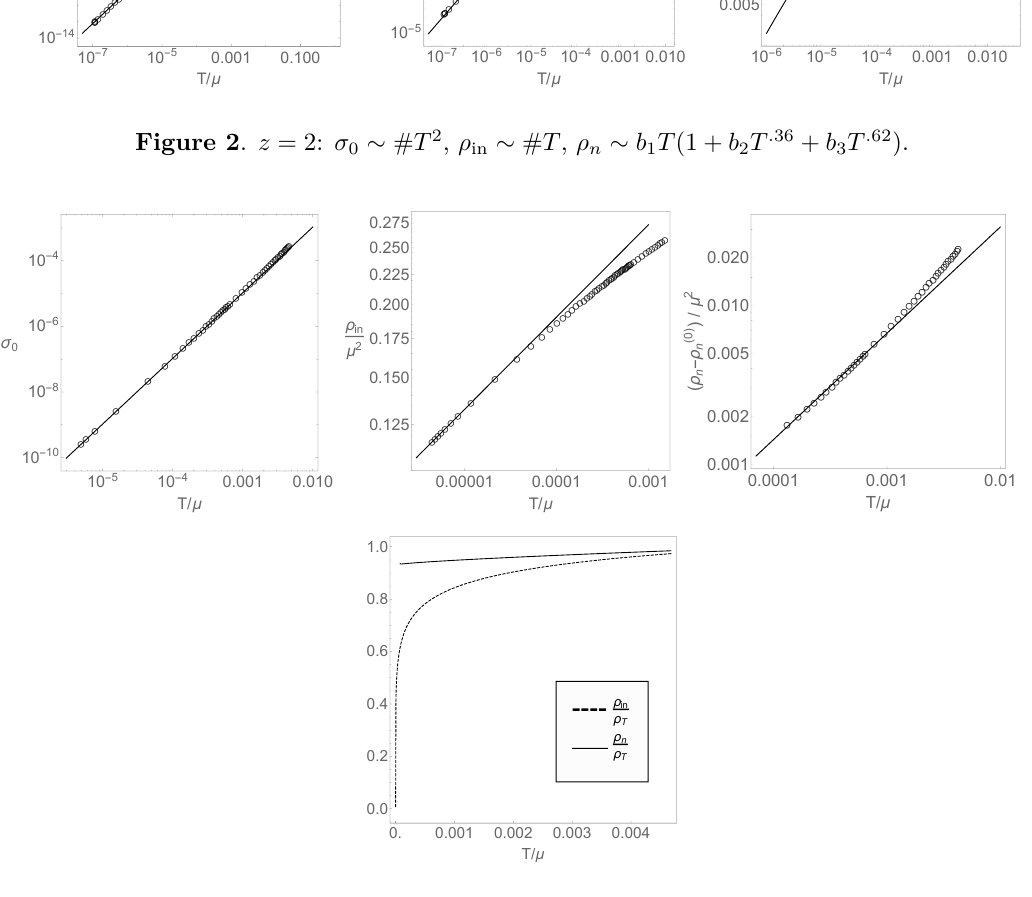
Figure 3 . z = 12 : σ 0 ∼ # T 2 , ρ in ∼ # T 1 / 6 , ρ n ∼ ρ (0) n + # T 2 / 3